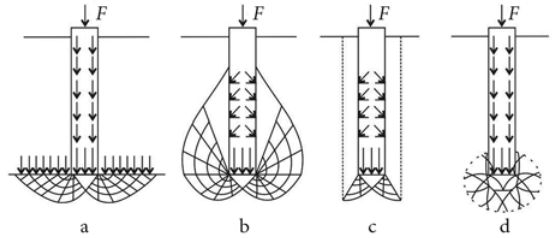
fig. 2. Assumed failure patterns under deep foundations: a – after